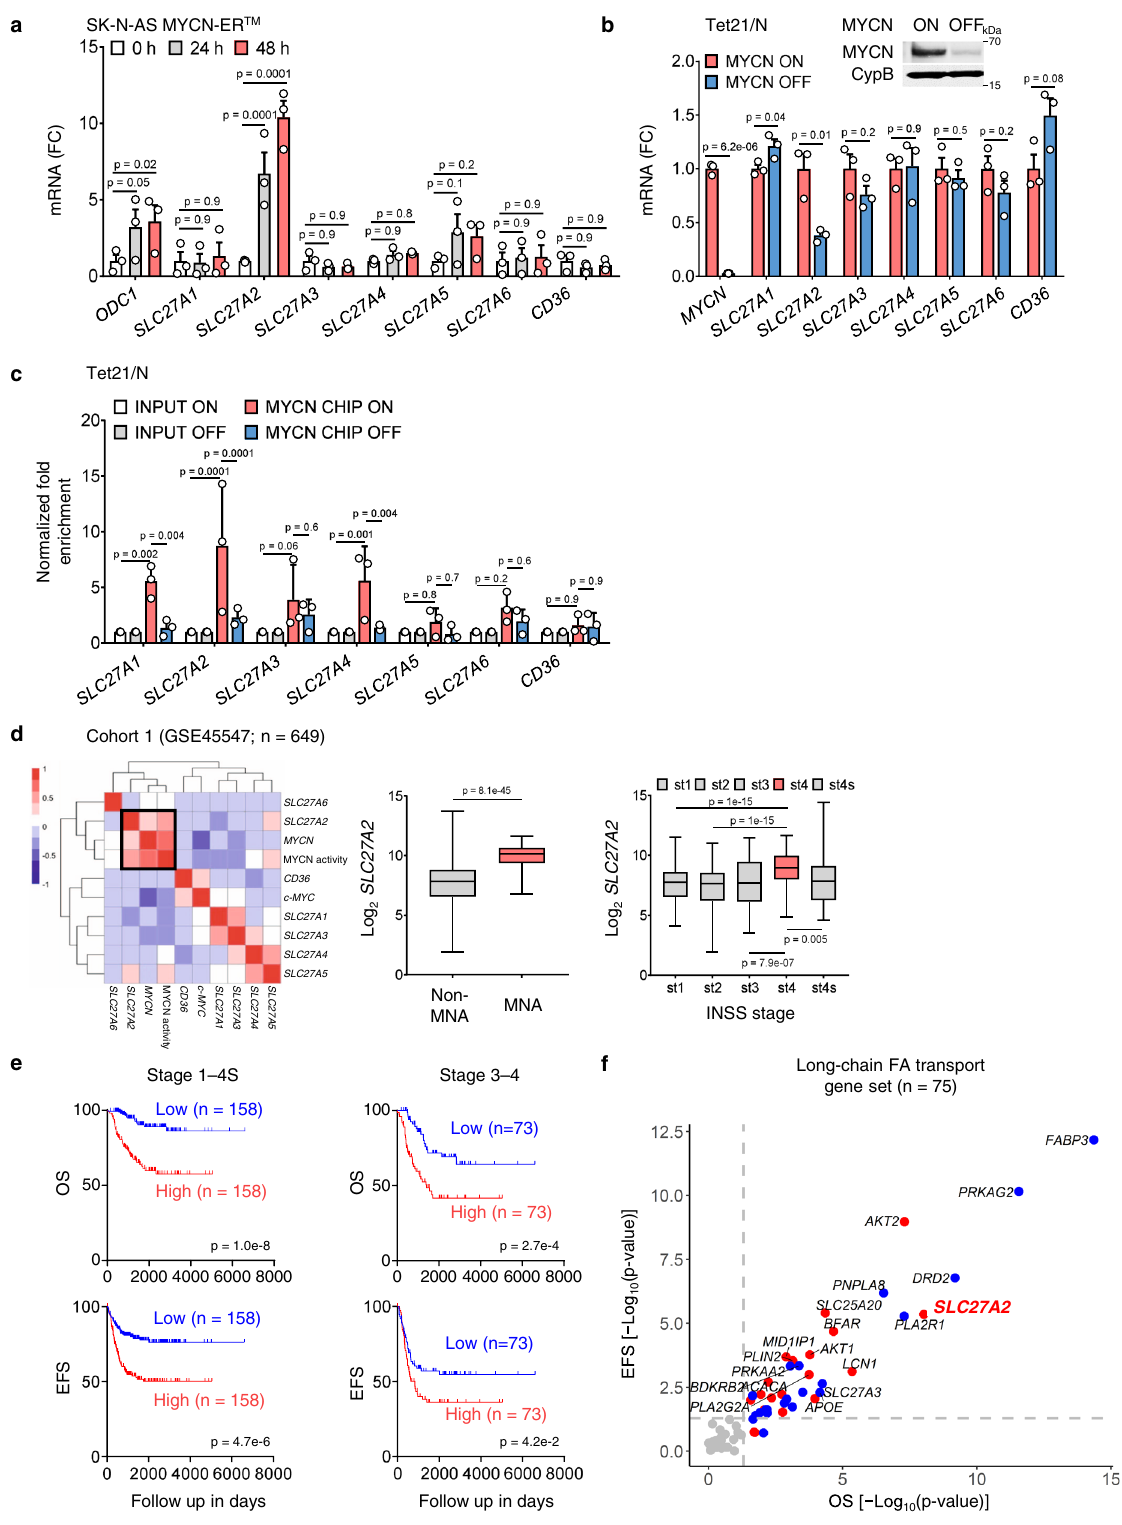
selective cytotoxicity against NB cells but spares normal cells (Fig. 2b). We fi rst validated the ability of CB5 to block FA uptake in NB cells by both stable isotope tracing (Supplementary Fig. 2d) and staining with a fl uorescent-labeled FA analog BODIPY ™ 500/ 510 C1, C12. CB5 preferentially blocked FA uptake in MNA LAN5 cells ( p < 0.05) compared with non-MNA SHEP cells (Fig. 4i). Because the FATP2 inhibitor CB16.2 also suppresses